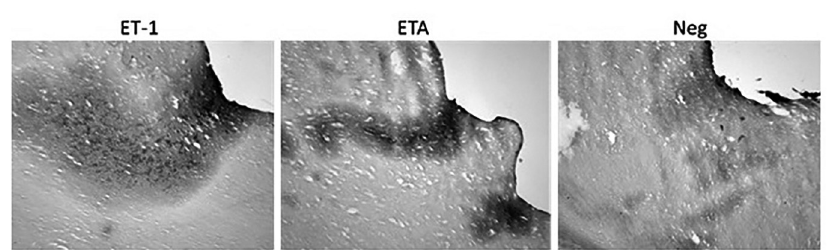
Fig. 1 - ET-1 and ETA receptor immunostaining at inflammatory and calcified regions of stenotic mitral valve. Neg=negative